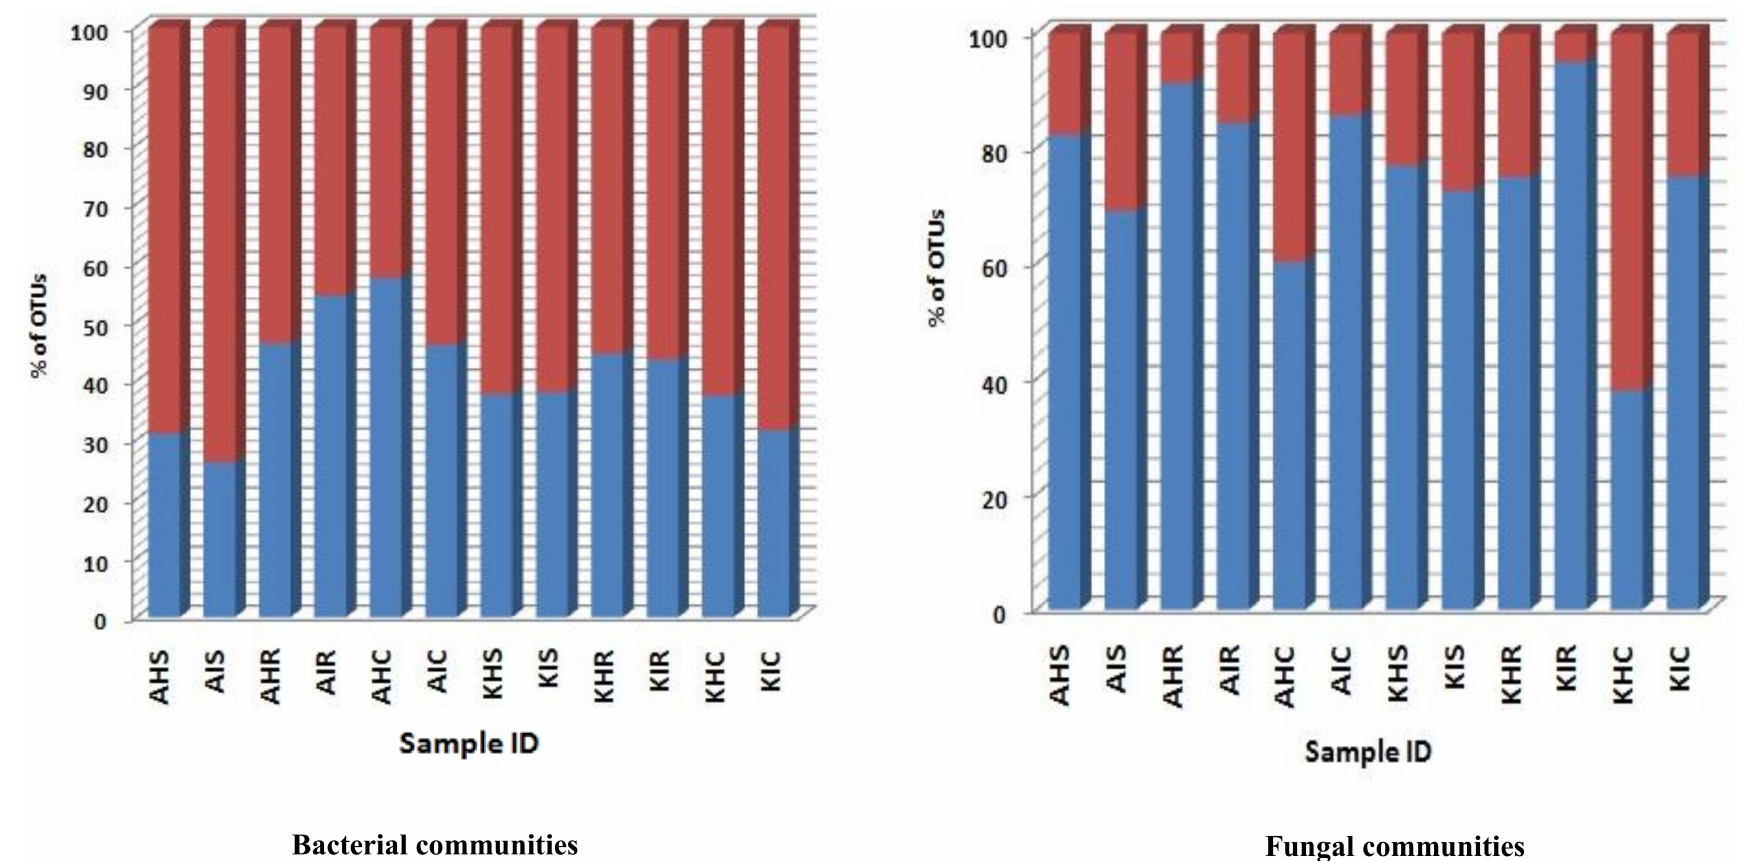
Figure 6. Relative abundance of OTU belonging to core and non-core OTUs. Blue bars represent relative abundance of core OTUs whereas red bars represent relative abundance of non-core OTUs. A: Arusha; C: Corm; H: Asymptomatic; I: Symptomatic; K: Kilimanjaro; R: Roots; S: